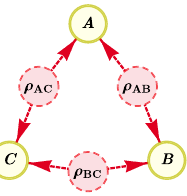
FIG. 9. The quantum triangle scenario, without settings. Each of the observable variables A , B , and C are dependent only on the sources of bipartite entanglement. This figure is essentially a reproduction of Fig. 1(b), the only difference being some added specificity regarding the quantum nature of the latent